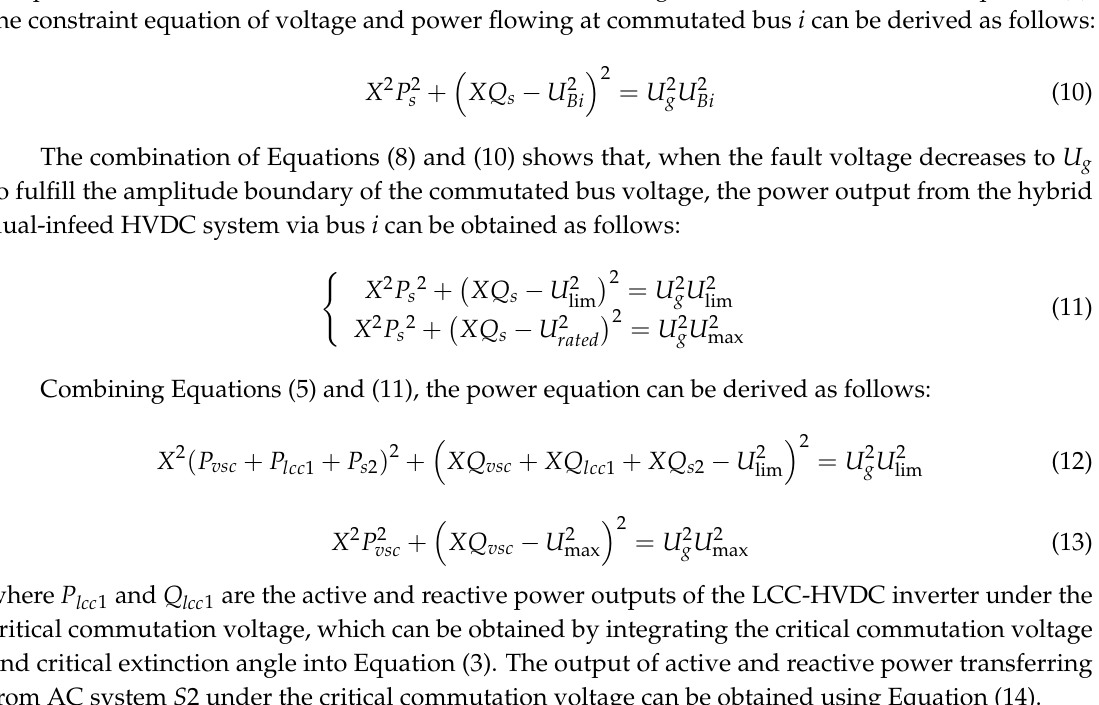
According to the voltage and power constraints of Equations (12) and (13), the blue and red curves shown in Figure 3 represent the set of power operation points of the VSC-HVDC inverter, which can fulfill the critical commutation voltage amplitude and the maximum allowable voltage amplitude of the commutated bus in the PQ coordinate, respectively. In Figure 3, the region surrounded by the blue and red dotted curves represents the power operating range of the VSC inverter that can avoid commutation